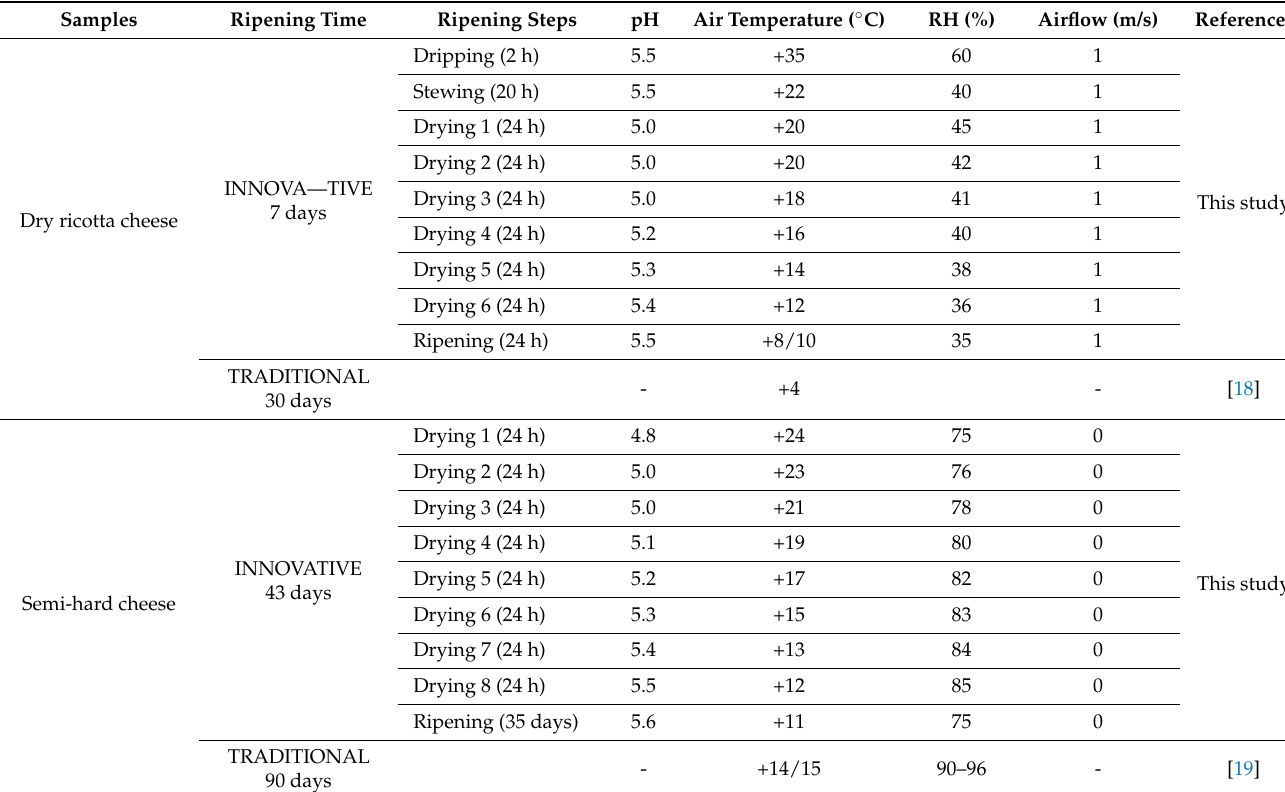
Table 1. Experimental ripening design for dry ricotta cheese and semi-hard